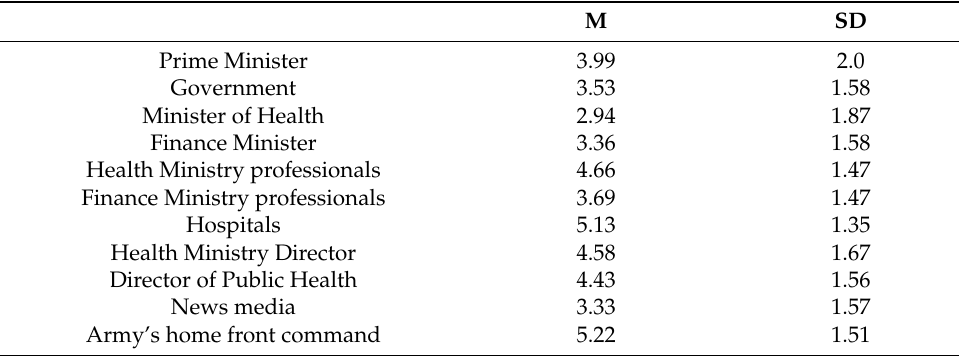
Table 3. Means and standard deviations for trust in various state agencies (1–7).